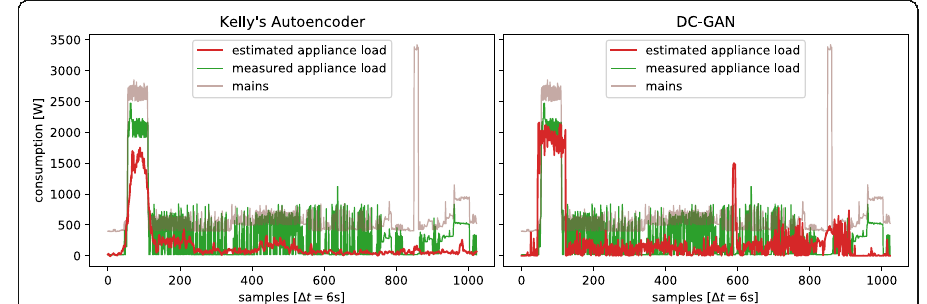
Fig. 2 Application of the disaggregation approaches on an exemplary appliance load sequence of the washing machine from the test data set. The output of the Kelly ’ s autoencoder is compared to the output of our DC-GAN based approach